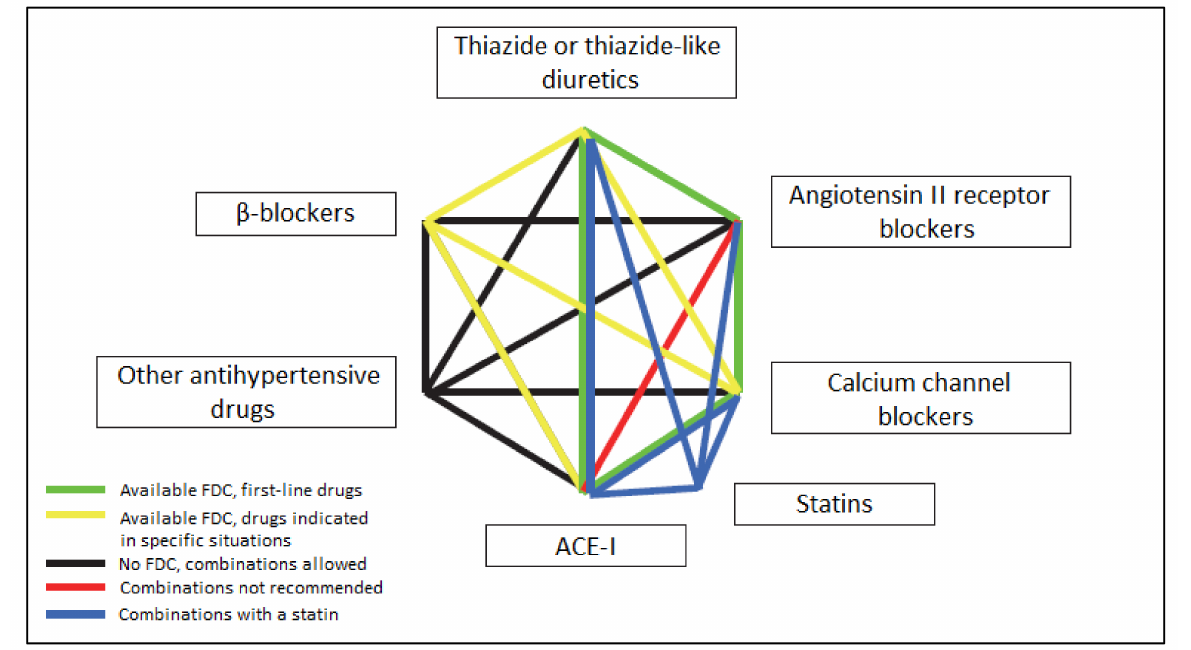
Figure 1. Combinations of antihypertensive drugs in dual-drug combination therapy, taking into account their usefulness and SPC availability